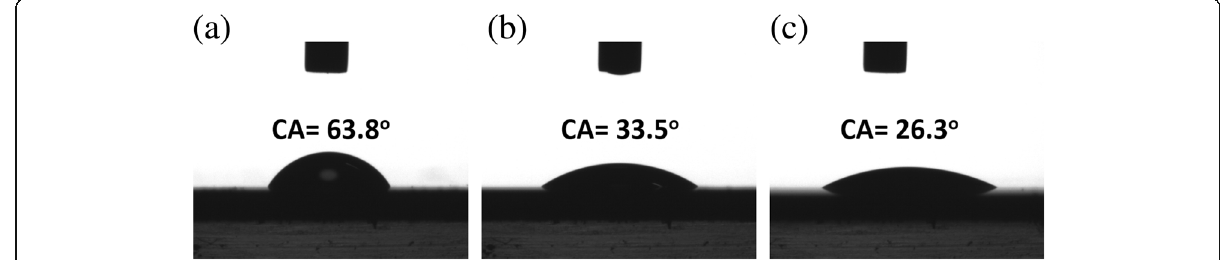
Fig. 5 Measured contact angles of a ZS nanowires, b CS nanowires, and c ZCS